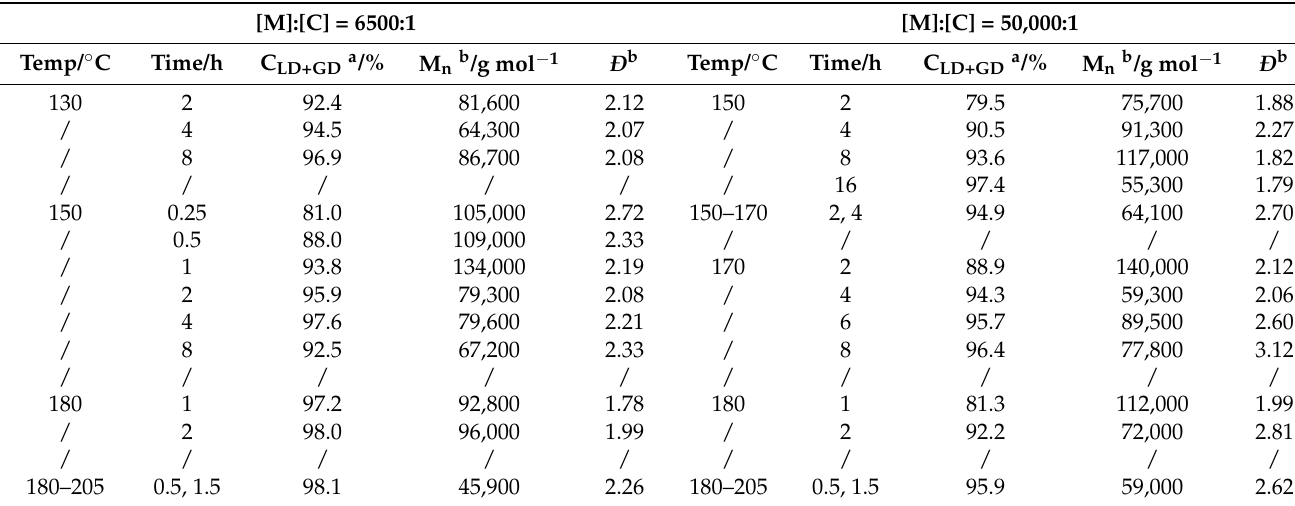
reaction temperature. Table 2. Conversion and molecular weight data for the synthesis of PLGA25 using different [M]:[C] ratios and [M]:[I] = 30,000:1. C LD+GD = total monomer